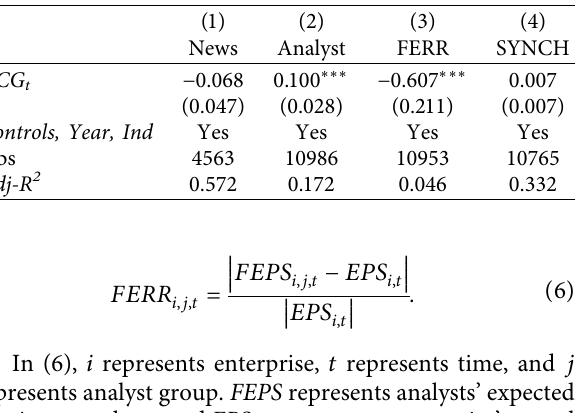
Table 6: Analysis of mechanism: information